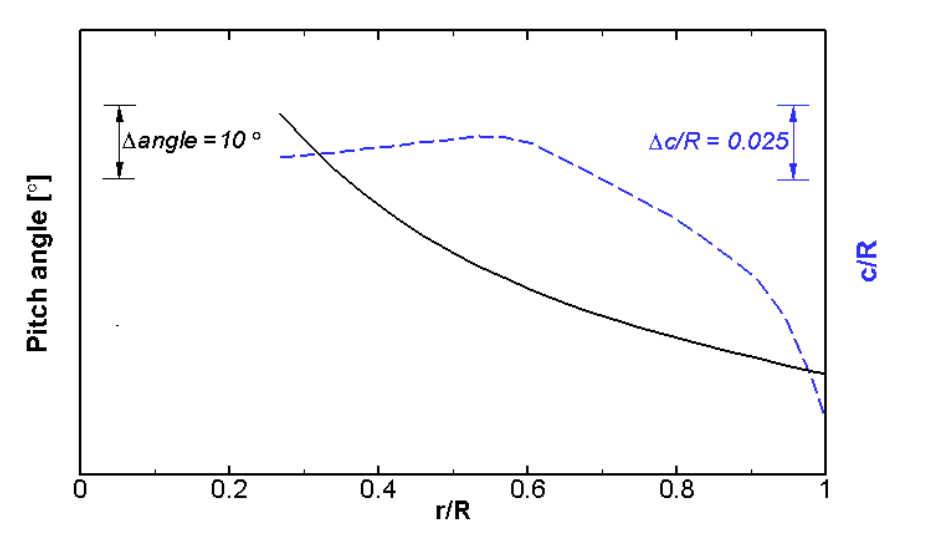
Figure 2. Blade geometry curves.